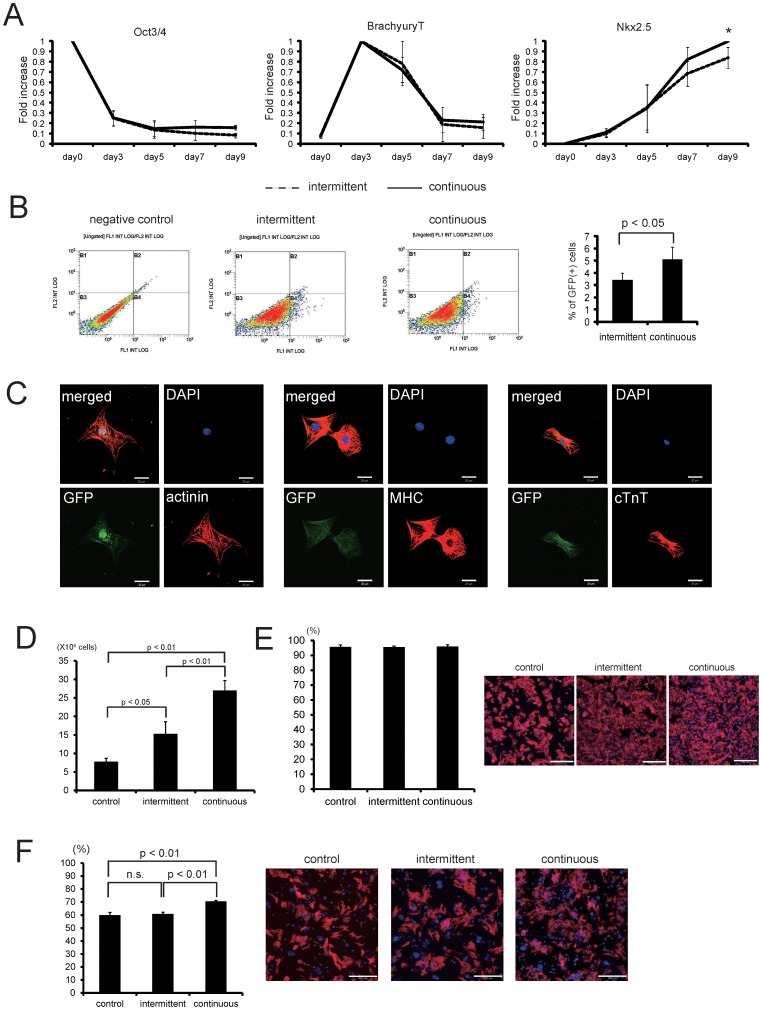
Cardiac differentiation of ES cells in the bioreactor.(A) Real-time PCR analysis (n = 3). Solid lines indicate the results of continuous medium exchange, and dotted lines indicate the results of intermittent medium exchange. *p<0.05. (B) Representative dot plots of flow cytometric analyses of GFP(+) cells in EBs at day 10. The graph shows the percentage of GFP(+) cells at day 10 (n = 6). (C) GFP(+) cells were collected using a fluorescence-activated cell sorter and then seeded onto gelatin-coated dishes. GFP(+) cells expressed sarcomeric α-actinin (upper), myosin heavy chain (MHC, middle) and cardiac troponin T (lower) in a fine striated pattern. Nuclei were counterstained with DAPI. Scale bars, 20 µm. (D, E) Comparison of the numbers of cardiomyocytes among culture conditions using R1 ES cells. (D) The number of remaining cells 8 days after starting culture with G418 (n = 3). Data are means ± s.d. (E) At 8 days after starting culture with G418 in the bioreactor with or without regulation, the cells were dissociated and seeded onto 1% gelatin-coated 24-well plates. At 24 h after seeding, the cells were fixed and immunostained for sarcomeric-α actinin. The percentage of sarcomeric α-actinin-positive cells among the remaining cells was calculated and is shown in the graph (n = 3). Data are means ± s.d. Right, representative images. Nuclei were stained with DAPI. Bars, 200 µm. (F) Comparison of cardiomyocyte engraftment between medium exchange systems. Purified cardiomyocytes after treatment with G418 were co-cultured with fibroblasts at the ratio of 8∶2. At day 2, cells were fixed and immunostained with cTnT. The percentage of cTnT-positive cells was calculated and is shown in the graph (n = 3). Data are means ± s.d. n.s., not significant. Right, representative images. Nuclei were stained with Hoechst33258. Bars, 200 µm.